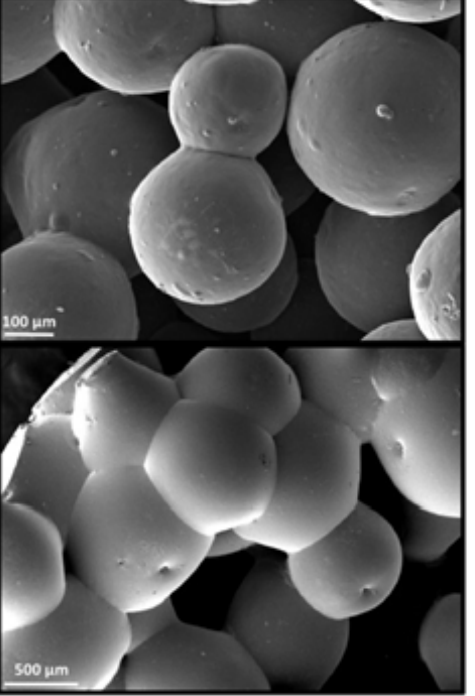
Figure 8. SEM images of microsphere based sintered scaffolds, using PCL/0.5%TNT (TiO2 Nanotube) at 100 µ m and 500 µ m. Reprinted with permission from Ref. [159], Copyright 2021, AIP pub ‐ lishing.